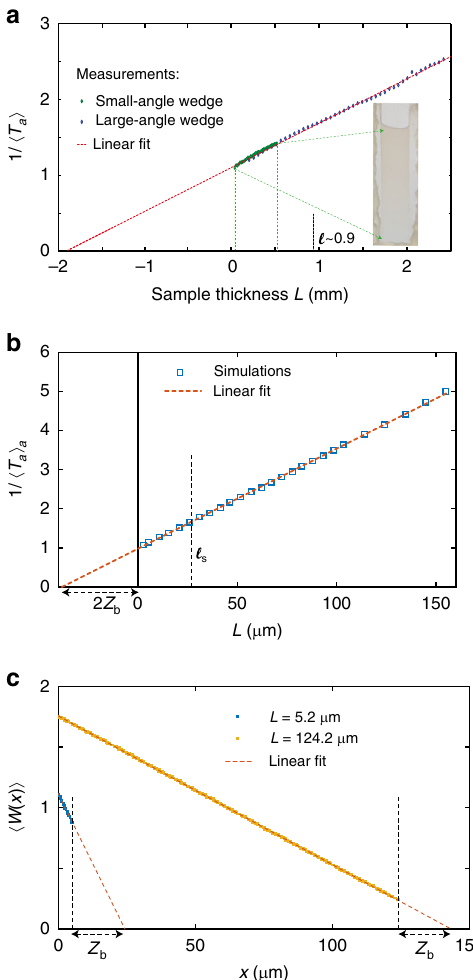
even in translucent samples.